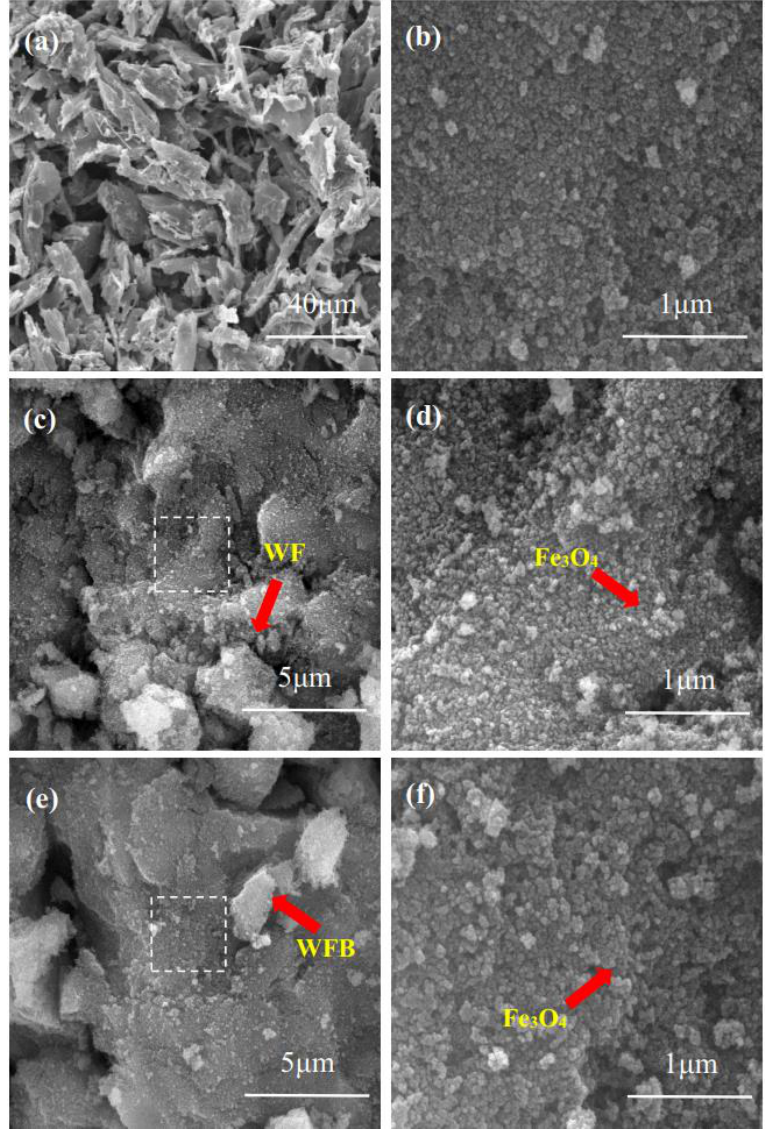
Figure 1. SEM images of ( a ) WFB, and FESEM images of ( b ) Fe 3 O 4 , ( c , d ) WF 20 /Fe 3 O 4 , and ( e , f ) WFB 20 /Fe 3 O 4 (( d ) and ( f ) are the enlarged view of the dotted boxes shown in ( c ) and ( e ), respectively).